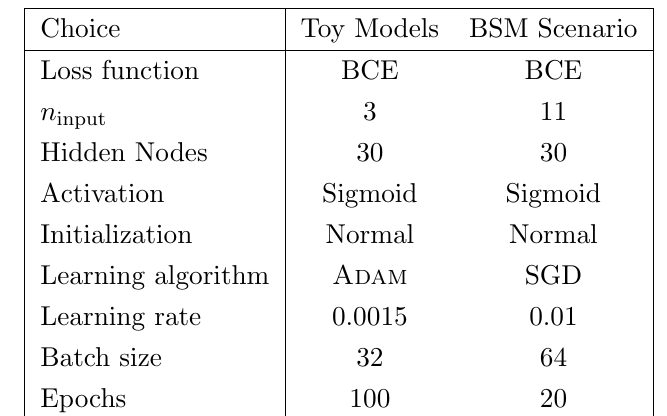
Figure 2 . Schematic of the data (cid:13)ow. We are given (at least) two data sets and told to learn two di(cid:11)erent classes (yellow and green), without knowing the truth value of any one event. Instead, each event is only labeled with the ratio of yellows to the total that are in its dataset. The datasets are combined and shu(cid:15)ed into batches, that are used for training. For illustration in this (cid:12)gure, the batch size is four, and this represents one random permutation.